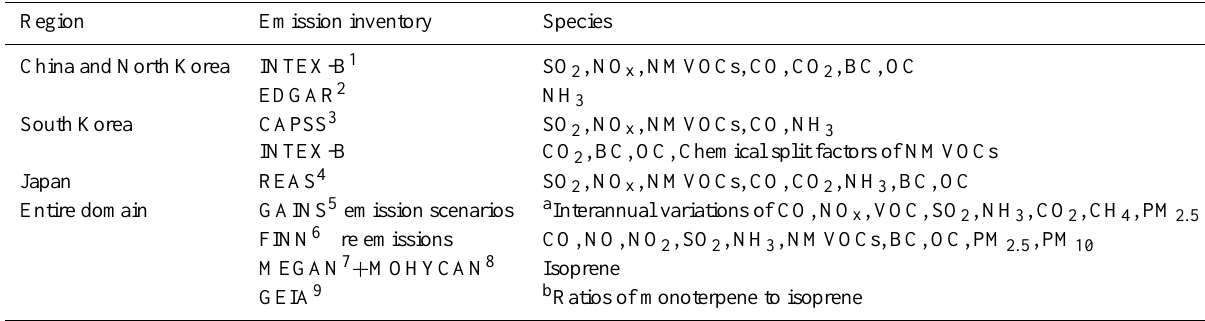
Table 2. Emission inventories used in the CMAQ model simulations. Region